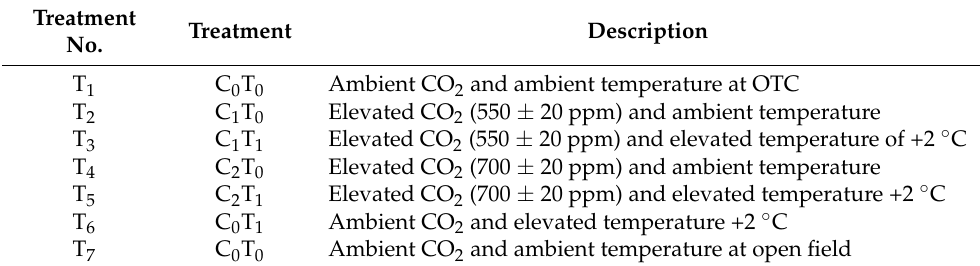
Table 1. Treatment details of the